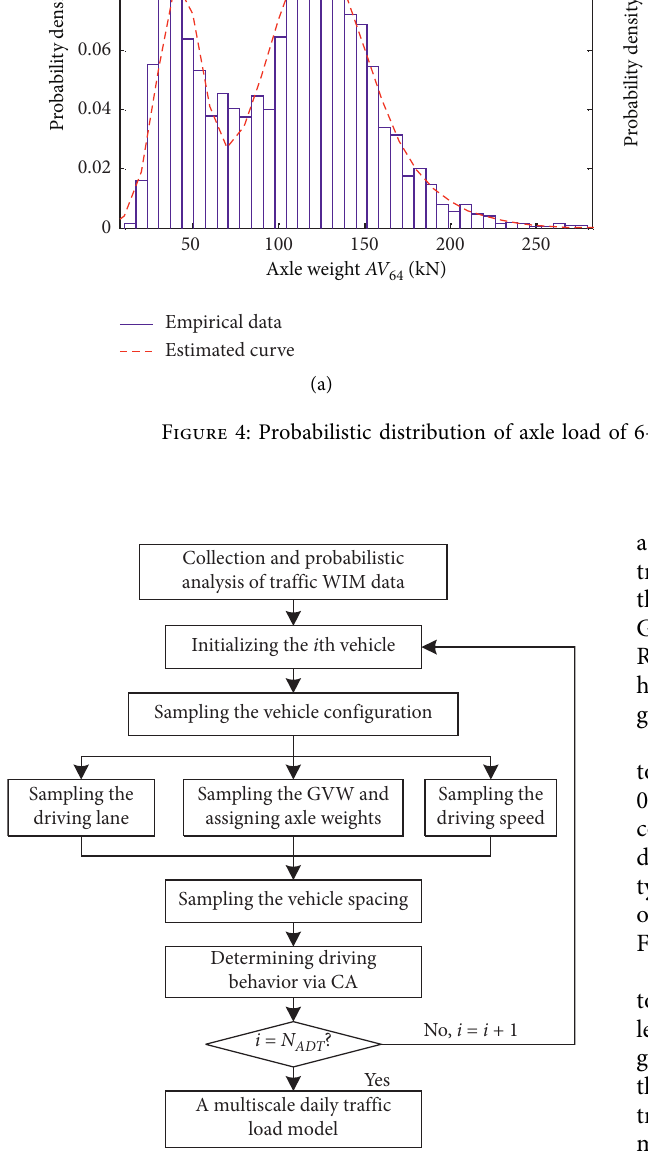
Figure 5: Procedures of stochastic vehicle flow